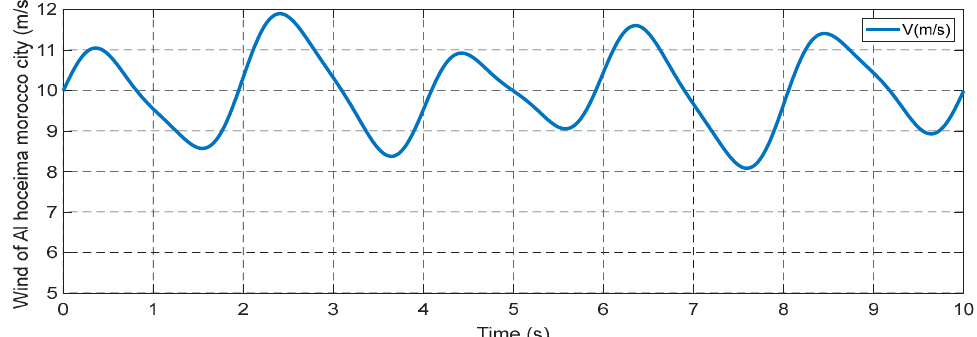
Figure 12. Wind speed profile of Al Hoceima City.